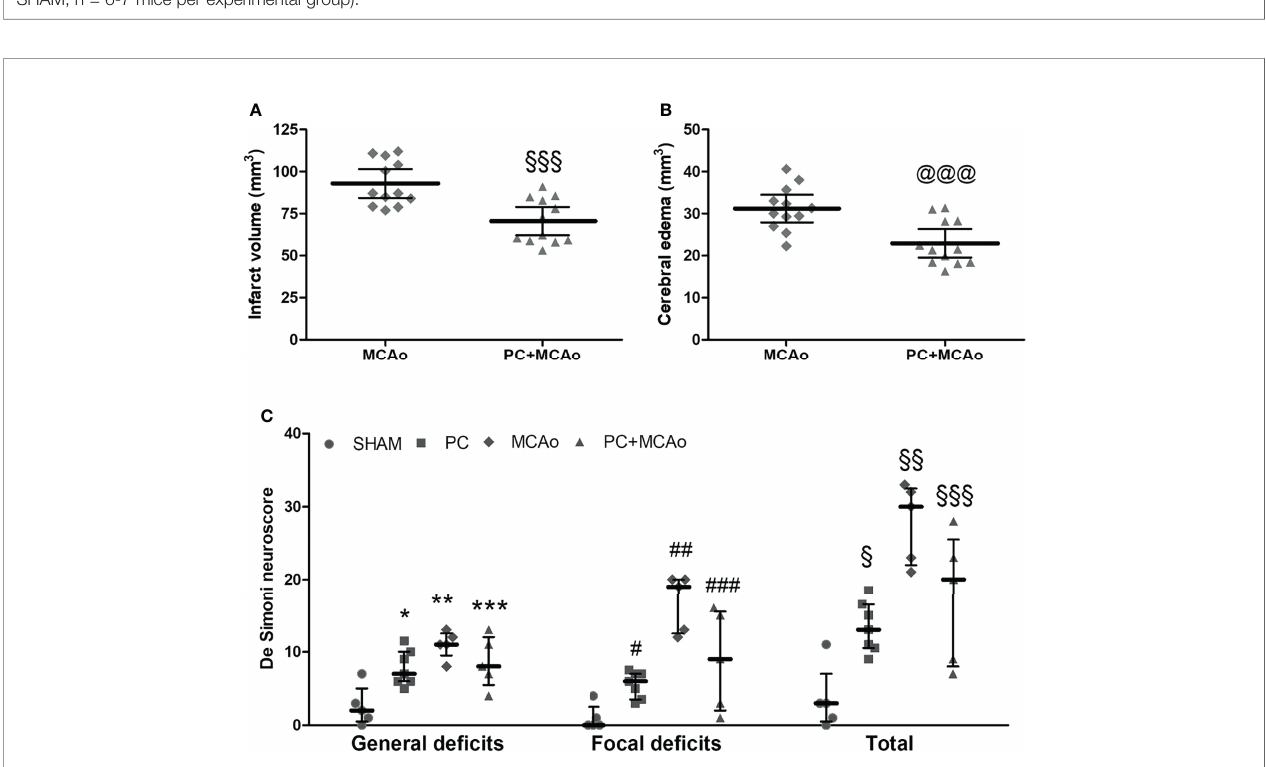
FIGURE 6 | Ischemic PC signi fi cantly reduces brain damage and neurological de fi cits caused by 1h MCAo. (A) Cerebral infarct volume and (B) brain edema in mice subjected to 1h MCAo followed by 24h of reperfusion preceded 72h before by sham surgery (MCAo) or by ischemic PC (PC+MCAo); §§§ P = 0.0005 and @@@ P = 0.0009 vs MCAo (unpaired t-test, n = 12 mice per experimental group). (C) General, focal and total de fi cits caused in mice by SHAM surgery, ischemic PC (15min MCAo, followed by 72h of reperfusion), 1h MCAo followed by 24h of reperfusion (MCAo) or ischemic PC 72h before MCAo (PC+MCAo). Data were analysed by Kruskal-Wallis test followed by Bonferroni ’ s correction (*P = 0.0227 vs corresponding SHAM, **P = 0.0088 vs corresponding SHAM and P = 0.0182 vs corresponding PC, ***P = 0.0212 vs corresponding SHAM, # P = 0.0111 vs corresponding SHAM, ## P = 0.0080 vs corresponding SHAM and P = 0.0044 vs corresponding PC, ### P = 0.0339 vs corresponding SHAM, § P = 0.0145 vs corresponding SHAM, §§ P = 0.0088 vs corresponding SHAM and P = 0.0045 vs corresponding PC, §§§ P = 0.0278 vs corresponding SHAM; n = 5-7 mice per experimental